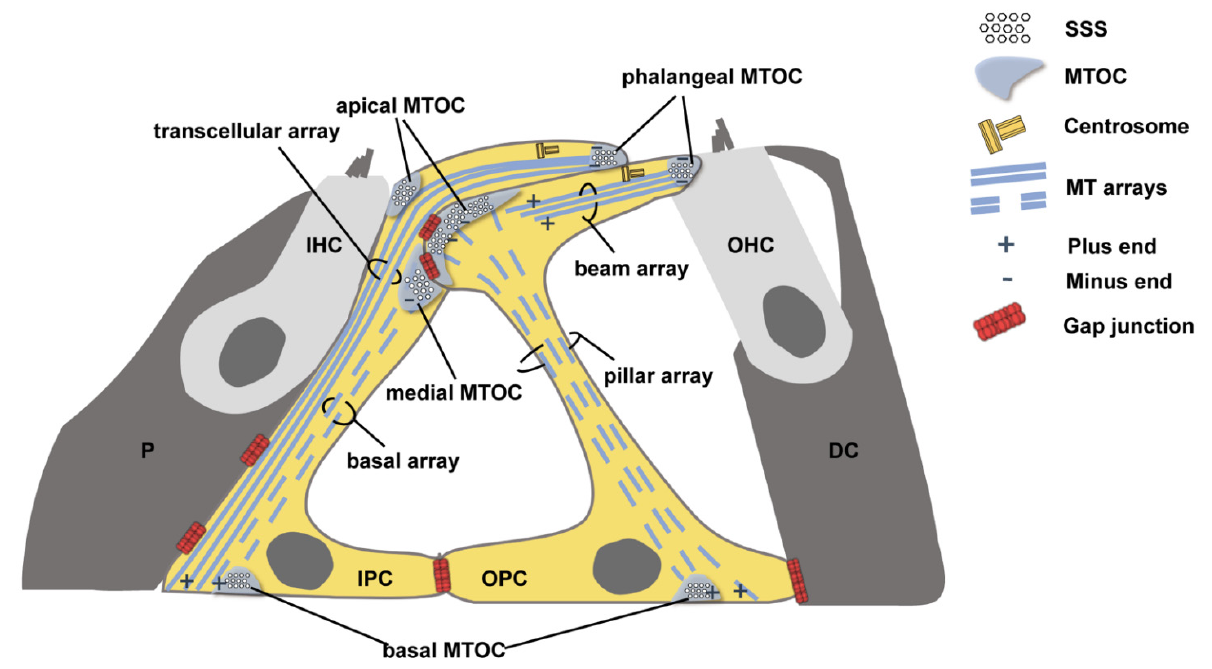
Figure 1. Schematic diagram showing the non-centrosomal MTOCs and the arrangement of MT arrays in PCs. The surfoskelosomes (SSSs) are assembled at MTOCs of PCs and connect MT ends to the cell surface. MTOC: microtubule-organizing center, SSS: surfoskelosome, MT: microtubule, IHC: inner hair cell, OHC: outer hair cell, IPC: inner pillar cell, OPC: outer pillar cell, P: inner phalangeal cell, DC: Deiters’ cell.